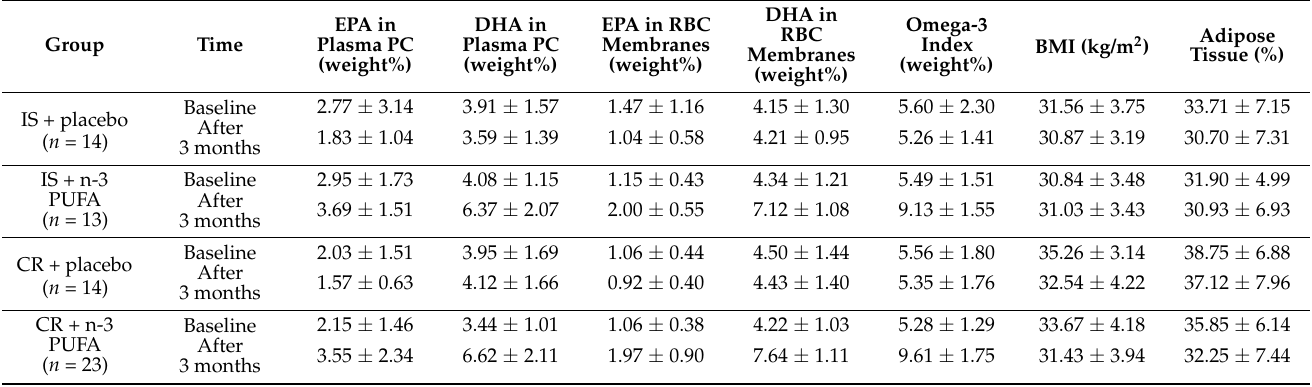
Table 2. Anthropometric values and n-3 PUFAs in plasma PC and red blood cells before and after 3 months of dietary intervention in obese